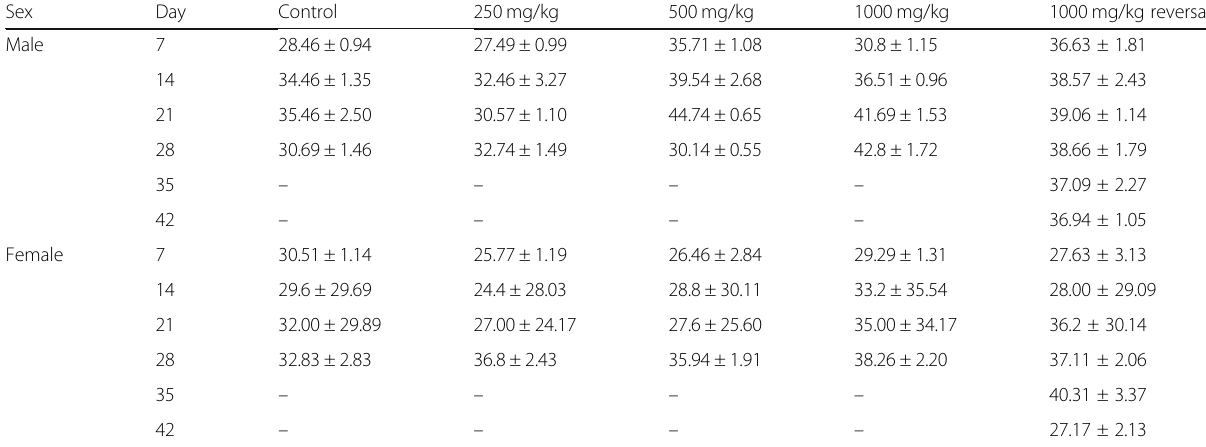
Table 2 Effect of Asdamarin on average water consumption (mL) in